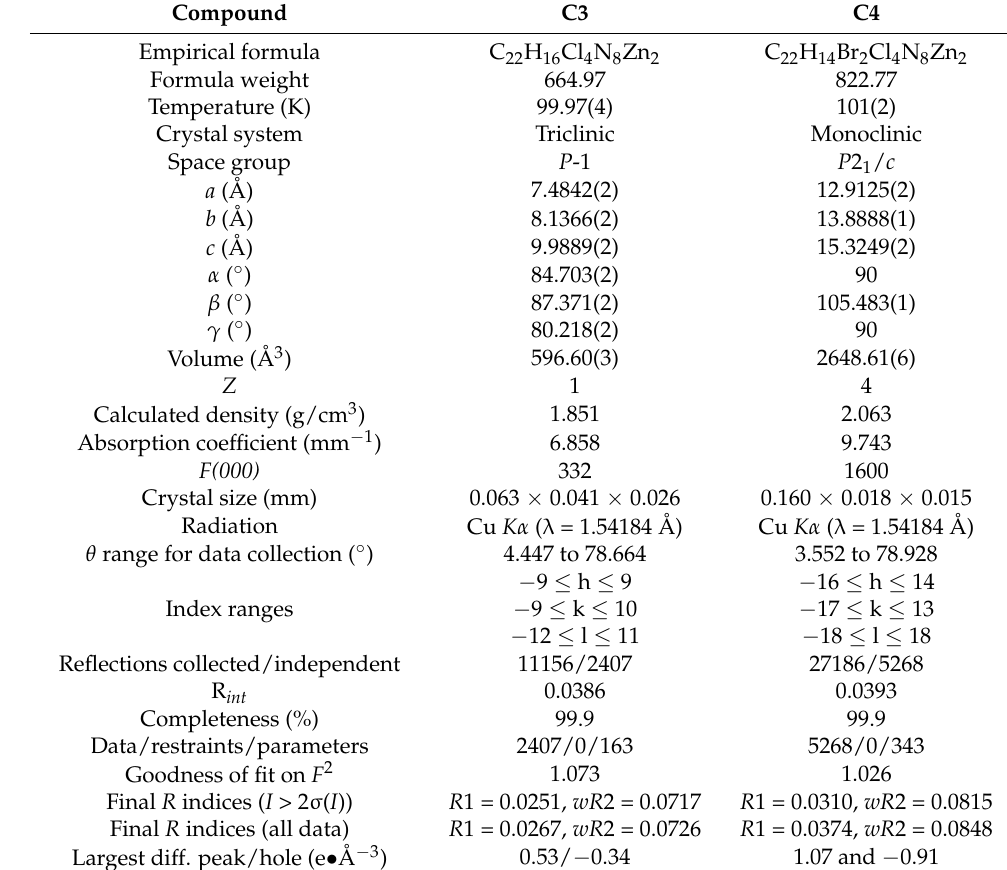
Table 9. X-ray diffraction data and structure refinement details for C3 and C4